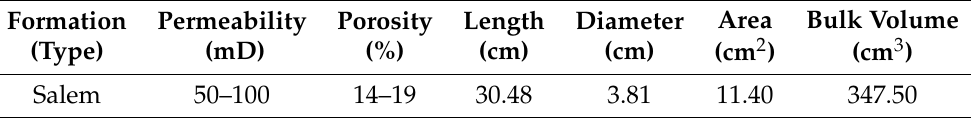
Table 6. Average properties of Indiana limestone (ILS) core sample as received from the company supplier (KOCUREK Industries Inc., Caldwell, Texas,